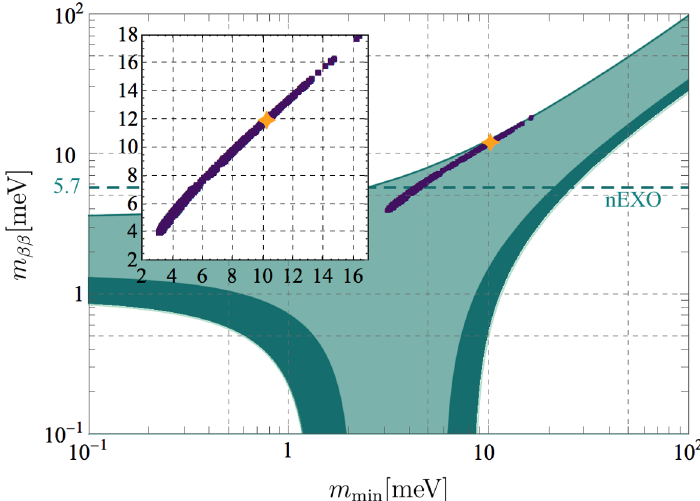
Figure 4 . The effective Majorana neutrino mass parameter m ββ against m min = m ν 1 . The green shadow is the allowed for NO scenarios. The dashed line corresponds to the future sensitivity ex- pected from the nEXO experiment. The inner plot zooms in the correlation between m ββ and m min